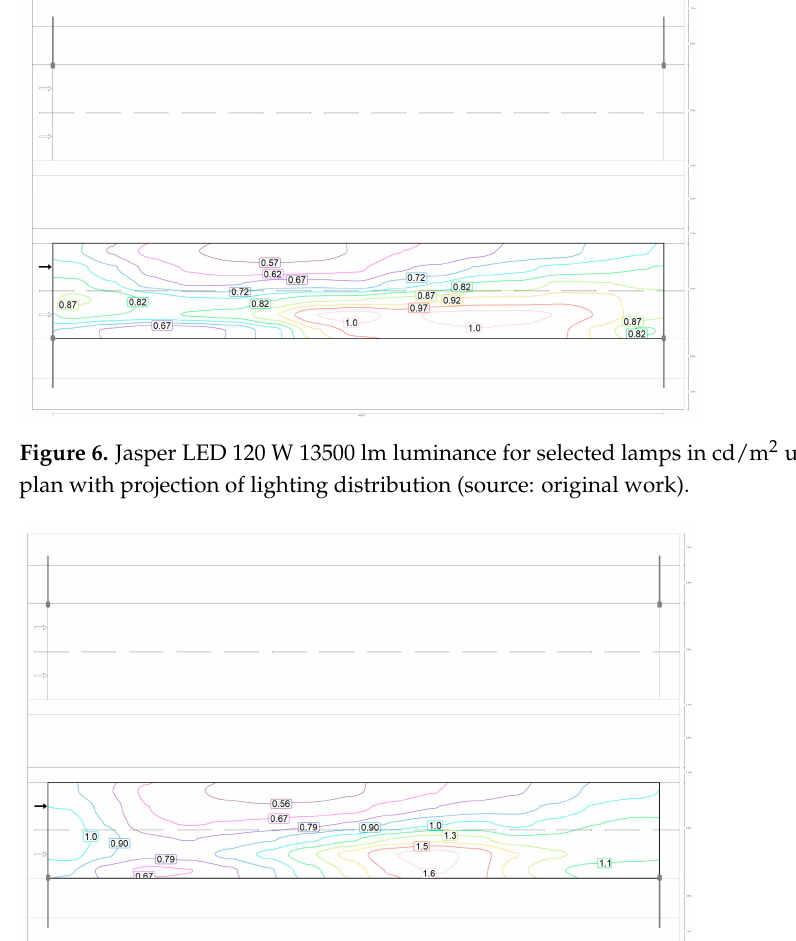
Figure 7. Philips LED 73 W 10440 lm luminance for selected lamps in cd/m 2 units. Value chart and plan with projection of lighting distribution (source: original work).